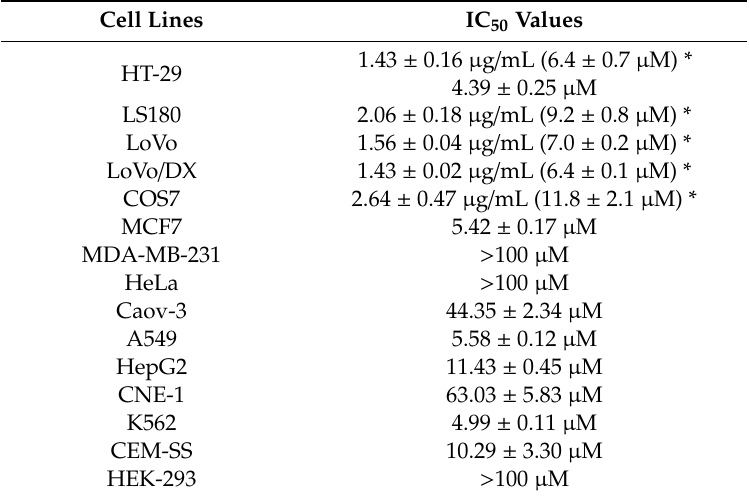
Table 10. Inhibitory e ff ect of compound 26 against the human colon cancer HT-29, LS180, LoVo, and LoVo / DX cell lines; estrogen-receptor-positive breast cancer cells MCF-7; triple-negative breast cancer (TNBC) cells MDA-MB-231; human cervical cancer cells HeLa; human ovarian cancer cells Caov-3; human lung cancer cells A549; human liver cancer cells HepG2; human nasopharyngeal cancer cells CNE-1; human T-lymphoblastoid leukemia cells CEM-SS; human erythromyeloblastoid leukemia cells K562; and normal human embryonic kidney HEK-293 cells.